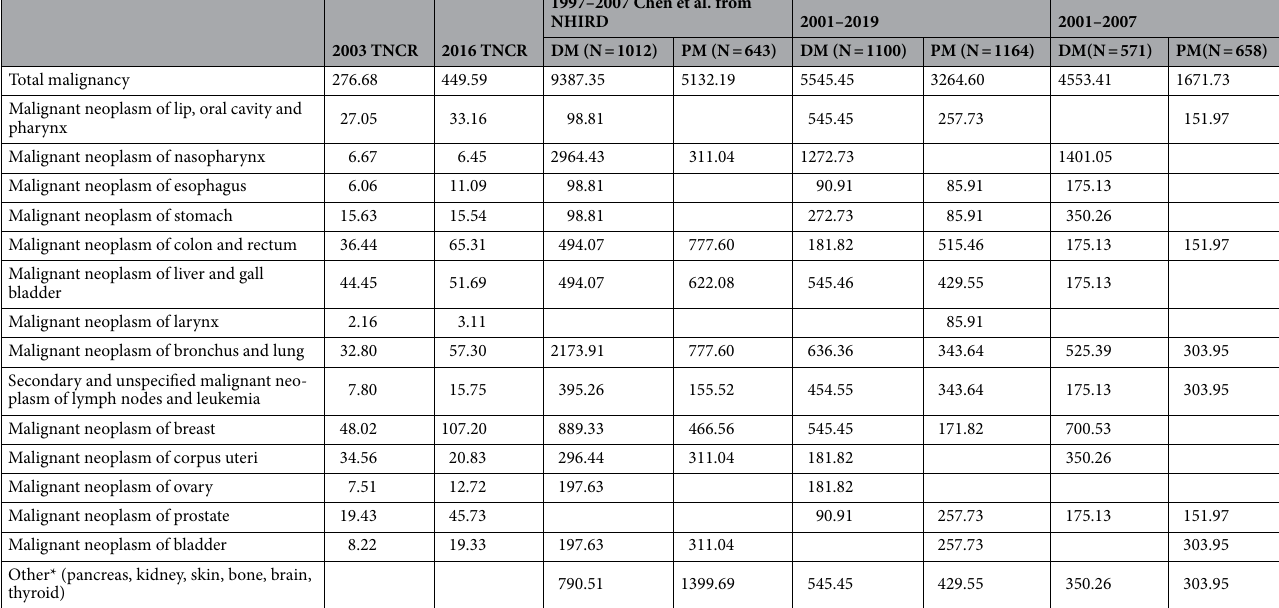
Table 5. Crude malignancy incidence (per 100,000 person) from Taiwan National Cancer Registry (TNCR), National Health Insurance Research Database (NHIRD) and current work. DM dermatomyositis, PM